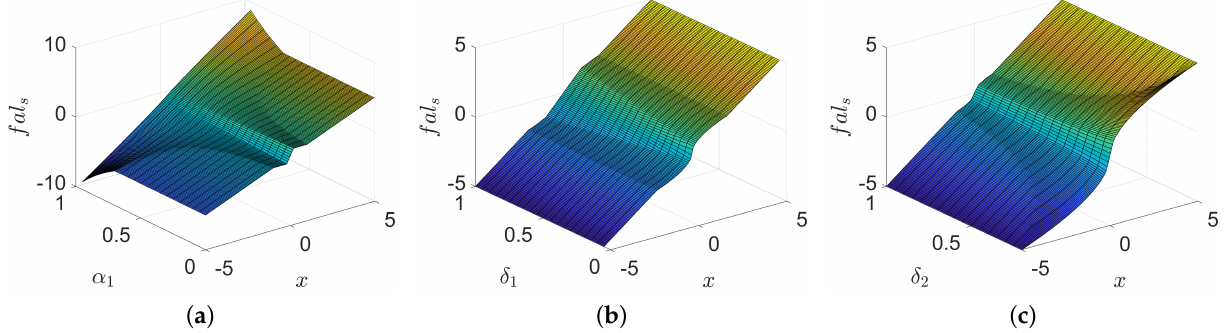
Figure 4. Effect of different parameter changes on f al s . ( a ) Three-dimensional diagram of the effect of parameter α 1 . ( b ) Three-dimensional diagram of the effect of parameter δ 1 . ( c ) Three-dimensional diagram of the effect of parameter δ 2